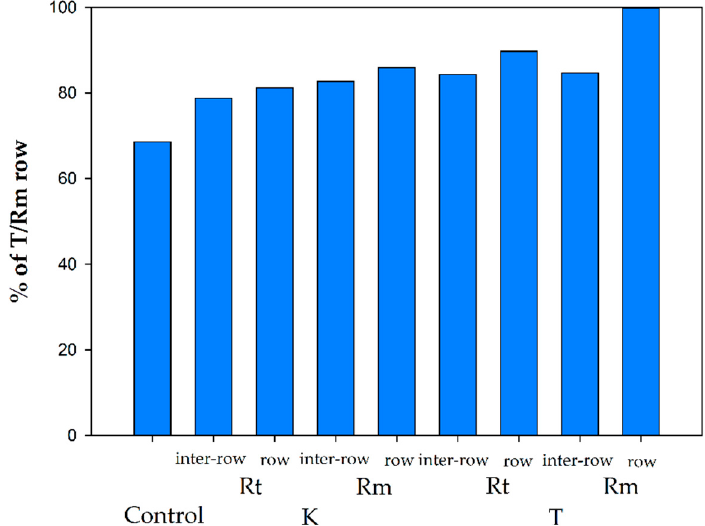
Figure A6. Non-replicated soil temperature heat units for residue return (Rt) and removal (Rm) after mowing management and banded herbicide (K) or zone tillage (T) row establishment and with unmanaged clover (Control) as a percentage of the T/Rm row. Heat units were the sum of the average maximum and minimum daily temperature measurements minus 10 °C.